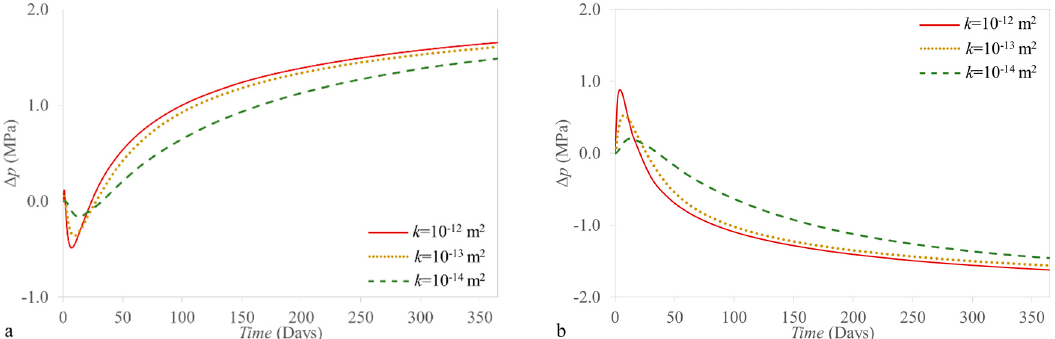
Figure 5. Liquid pressure during a 1-year injection and production period for a point at the bottom of the caprock placed 1.5 m above the reservoir-caprock interface and 30 m away from ( a ) the injection boundary and ( b ) the production boundary.